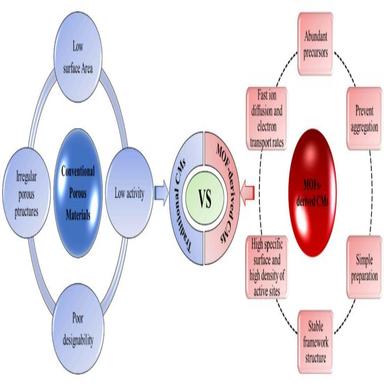
Comparison of MOFs-derived CMs and conventional CMs.